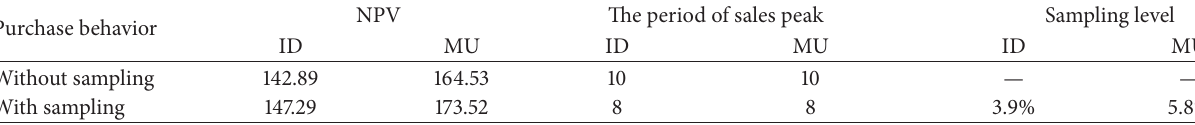
Table 1: Comparison of NPV with or without experience sampling.